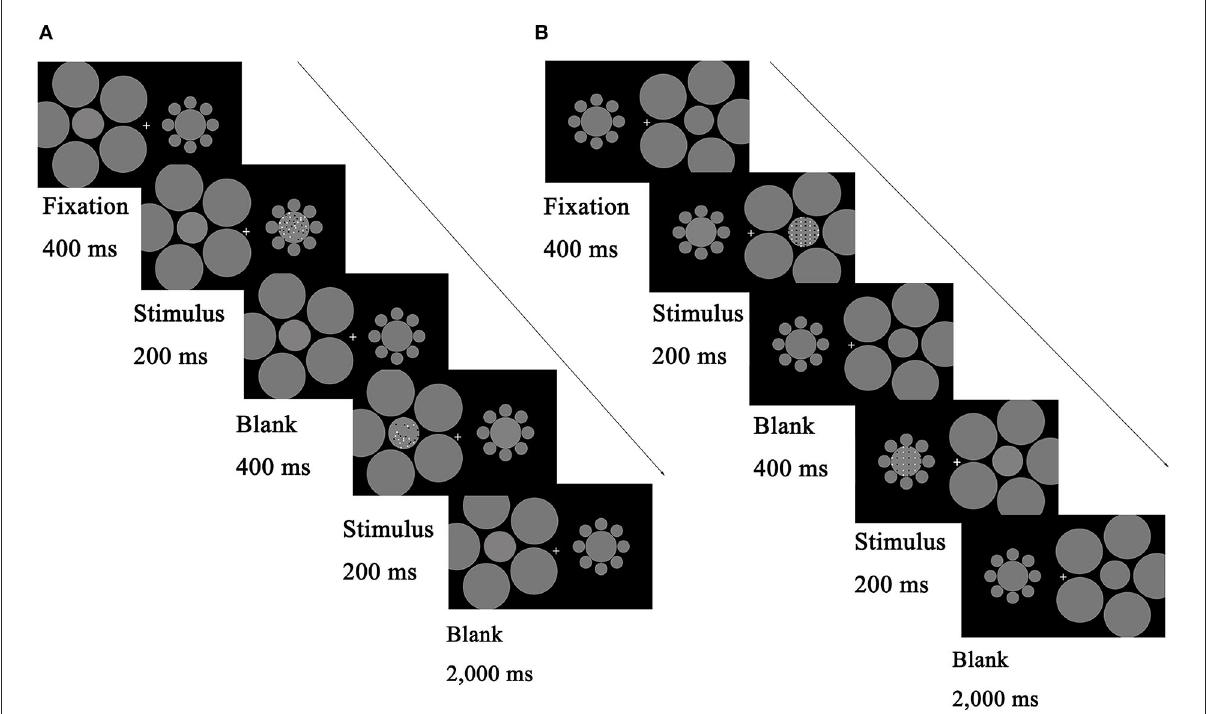
FIGURE2 Schematic illustration describing the procedure of the main tasks. Each trial began with a fixation for 400ms, and then the test stage began with test stimuli displayed on one side of the screen for 200ms, followed by reference stimuli on the other side for 200ms. The two stimuli were separated by a blank screen lasting 400ms. Participants reported which patterns (left or right) appeared to be denser/more numerous; they guessed when they were unsure. (A) Comparison task with random patterns. (B) Comparison task with regular patterns. The test and reference positions (left or right) and the presented patches (perceived to be smaller or larger) were counterbalanced across